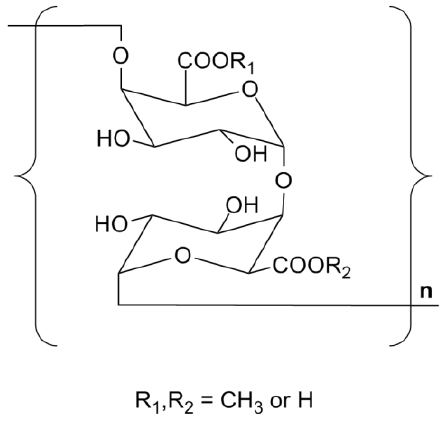
Figure 7. The basic chemical unit of TPS1-2a and